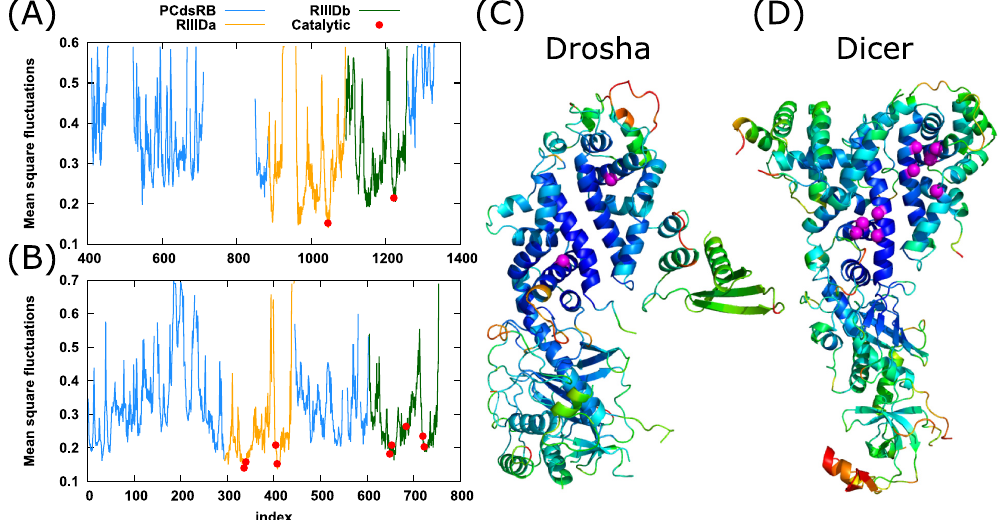
Fig 4. GNM mean-square fluctuations profile. Distribution of mean-square fluctuations (ordinate) as a function of residue index (abscissa) for (A) Drosha and (B) Dicer. Peaks represent the most mobile residues and minima the low mobility regions. Fragmented areas in the curve are UNK or missing residues in the PDB files. Curve colors are as follow: non catalytic domains (light blue; PCdsRB; platform, connector, dsRBD, bridging domain), RIIIDa (orange), RIIIDb (green). Catalytic residues are marked by filled red circles. (C) Drosha and (D) Dicer ribbon diagram is colored according to their MSF values. Warm and cold colors (red and blue scales, respectively) indicate most mobile and constrained regions, respectively. PCdsR designate: platform, connector, and dsRBD